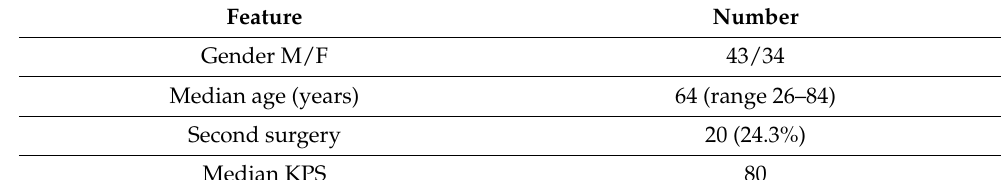
Table 1. Patients’ clinical characteristics.